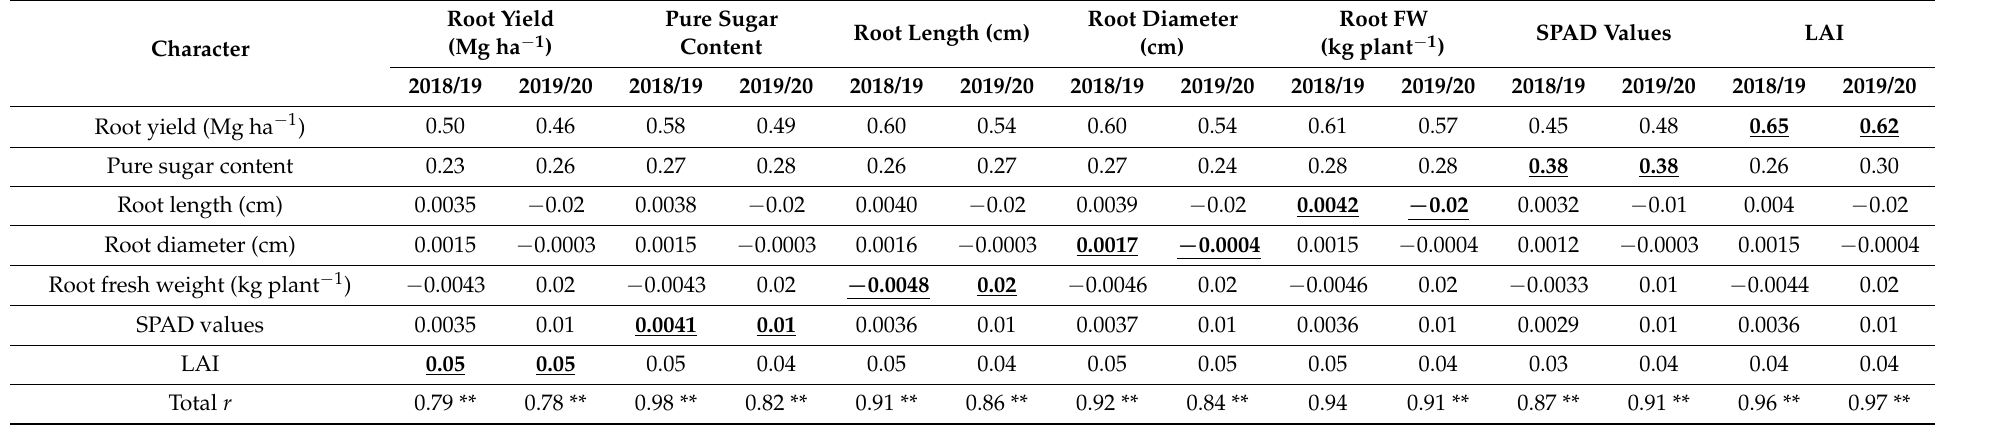
Table 8. Direct (bolded and underlined values), indirect effects of pure sugar yield (Mg ha − 1 ) components, and their correlations with pure sugar yield through two growing seasons under soil salinity (ECe = 8.96 dSm − 1 )